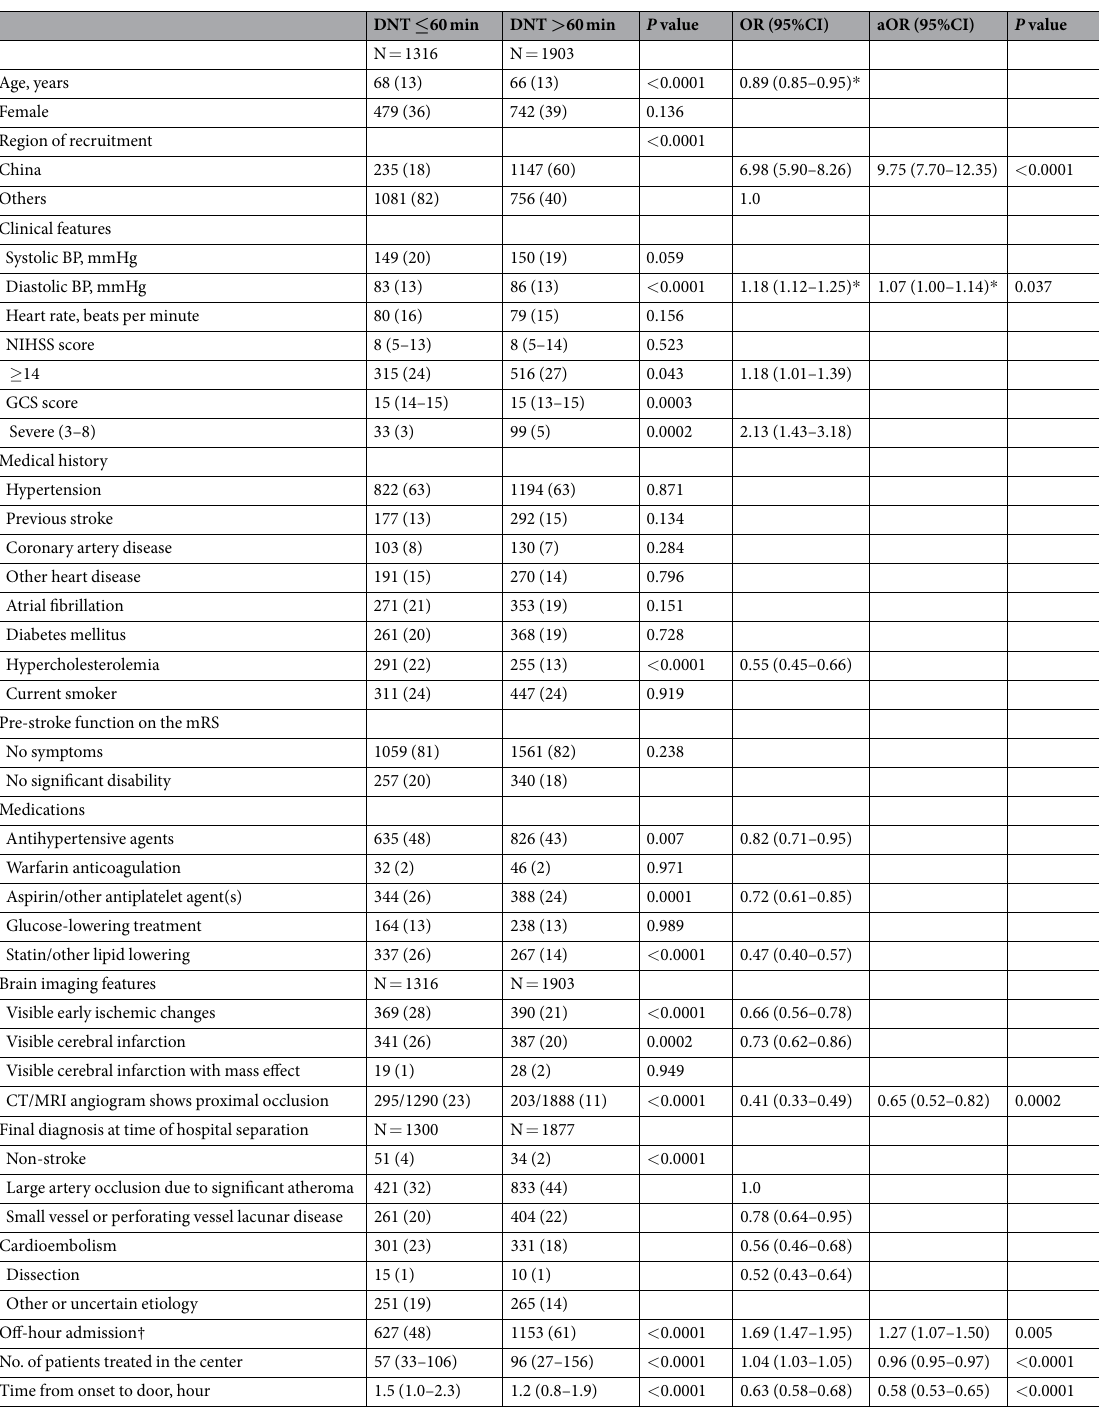
Table 1. Baseline characteristics of patients with acute ischemic stroke, according to door-to-needle time above and below 60 minutes for use of intravenous thrombolysis treatment. Data are n (%), mean (SD), or median (IQR)· P values based on Chi-square, T test, or Wilcoxon signed-rank test. aOR denotes adjusted odds ratio, BP blood pressure, CI confidence interval, CT computerized tomography, GCS Glasgow coma scale, mRS modified Rankin scale, MRI magnetic resonance imaging, NIHSS National Institutes of Health Stroke Scale, OR odds ratio. * For every 10-unit increase. †night time, weekend, and public